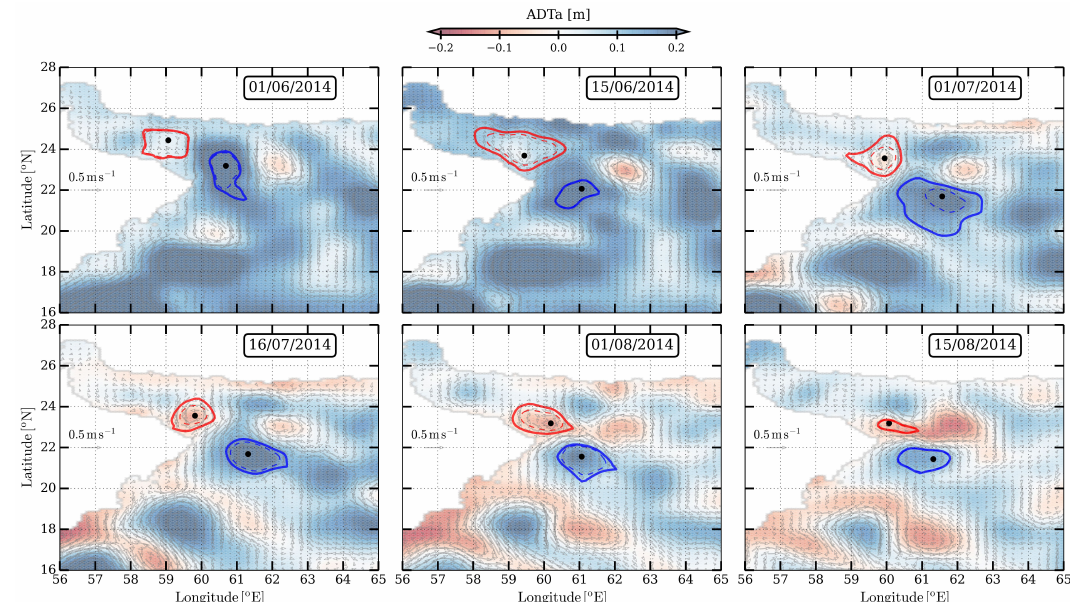
Figure 2. Snapshots of the Absolute Dynamic Topography (ADT) anomaly for the 2014 summer monsoon; the blue and red contours are for anticyclones and cyclones respectively; the dashed contours circle the eddy core; and solid lines indicate the outermost closed contours. The black dots represent the anticyclone and cyclone instantaneous center